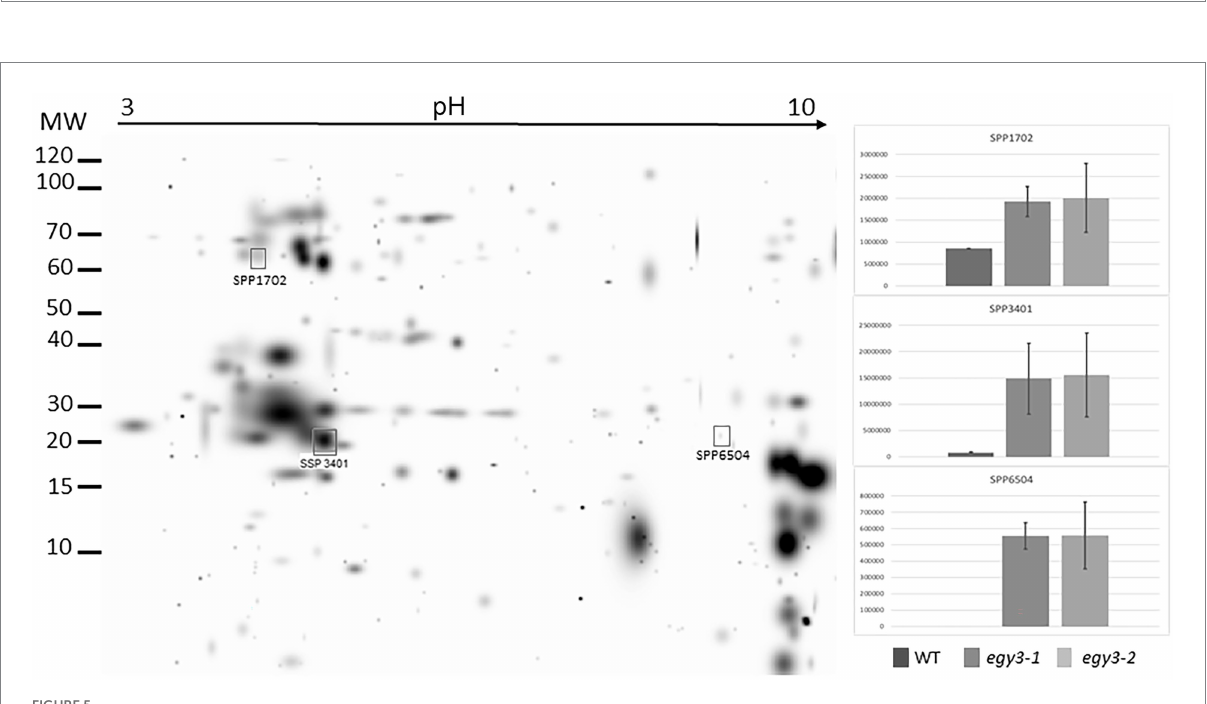
stroma fraction, two spots were absent in WT plants but present in both egy3 mutant lines, and three spots with a lower abundance in egy3 mutants were chosen. In the spots absent in WT plants, ACT